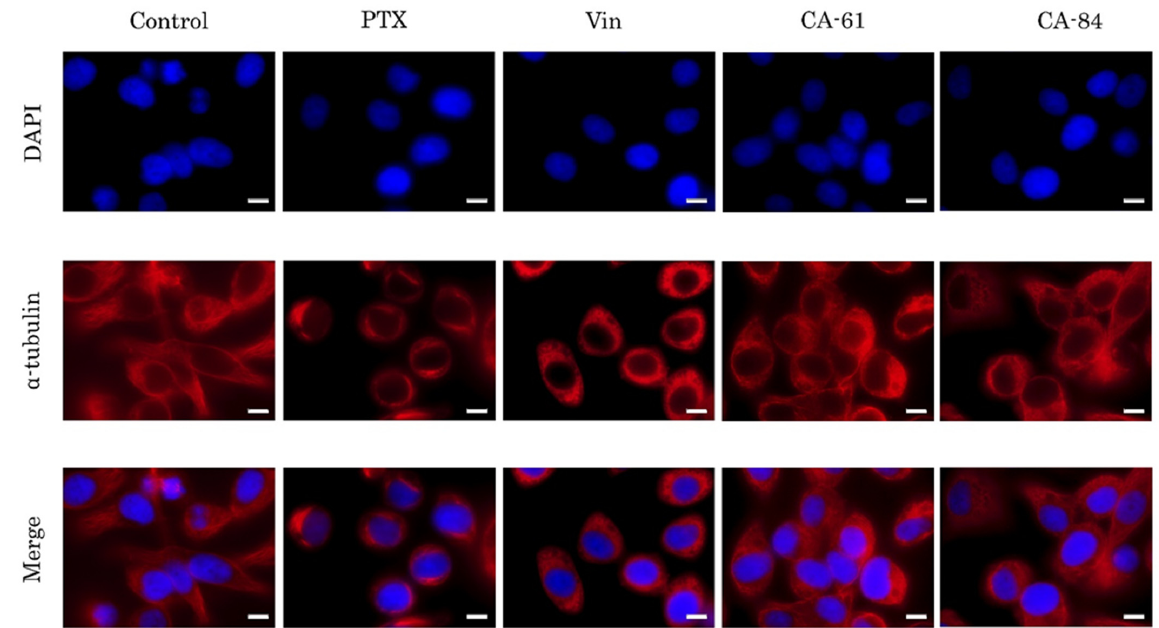
Figure 7. CAs disrupt the microtubules network in cancer cells. HCC1806 breast cancer cells were treated with DMSO (control), Paclitaxel (PTX-0.5 μ M), Vinblastine (Vin—0.01 μ M), CA-61 and -84 (10 μ M) for 9 h, fixed with a mixture of methanol and acetone, and stained with α -tubulin (red). DAPI nuclear staining (blue) was used to outline an equal number of cells. Images were captured by using a fluorescence Olympus BX63 microscope. Magnification 100×, scale bars 10 μ M. Molecules 2021 , 26 , x FOR PEER REVIEW